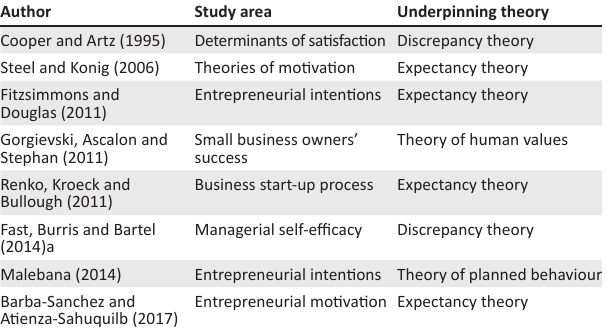
TABLE 1: Underpinning theories in previous